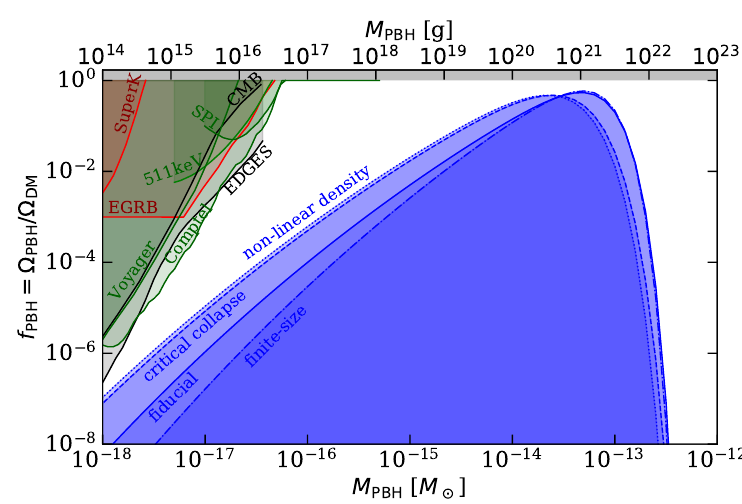
Figure 7 . The PBH mass function f ( M PBH ) (blue) based on the fiducial (Press-Schechter) ap- proach (C.1, solid line) and extended mass functions given by the effect of critical collapse (C.2, dashed), the finite-size effect (C.3, dash-dotted) and non-linear density contrast (C.4, dotted). The pivot scale k = 7 . 3 × 10 12 Mpc − 1 for the USR transition is used, and N in each function is fixed 0 ∗ by f = 1 with δ = − 3 . 05 and N = 20 . The existing observational bounds are shown from: PBH 2 end galactic (red) and extragalactic (green) probes, as well as CMB and Edges (black).